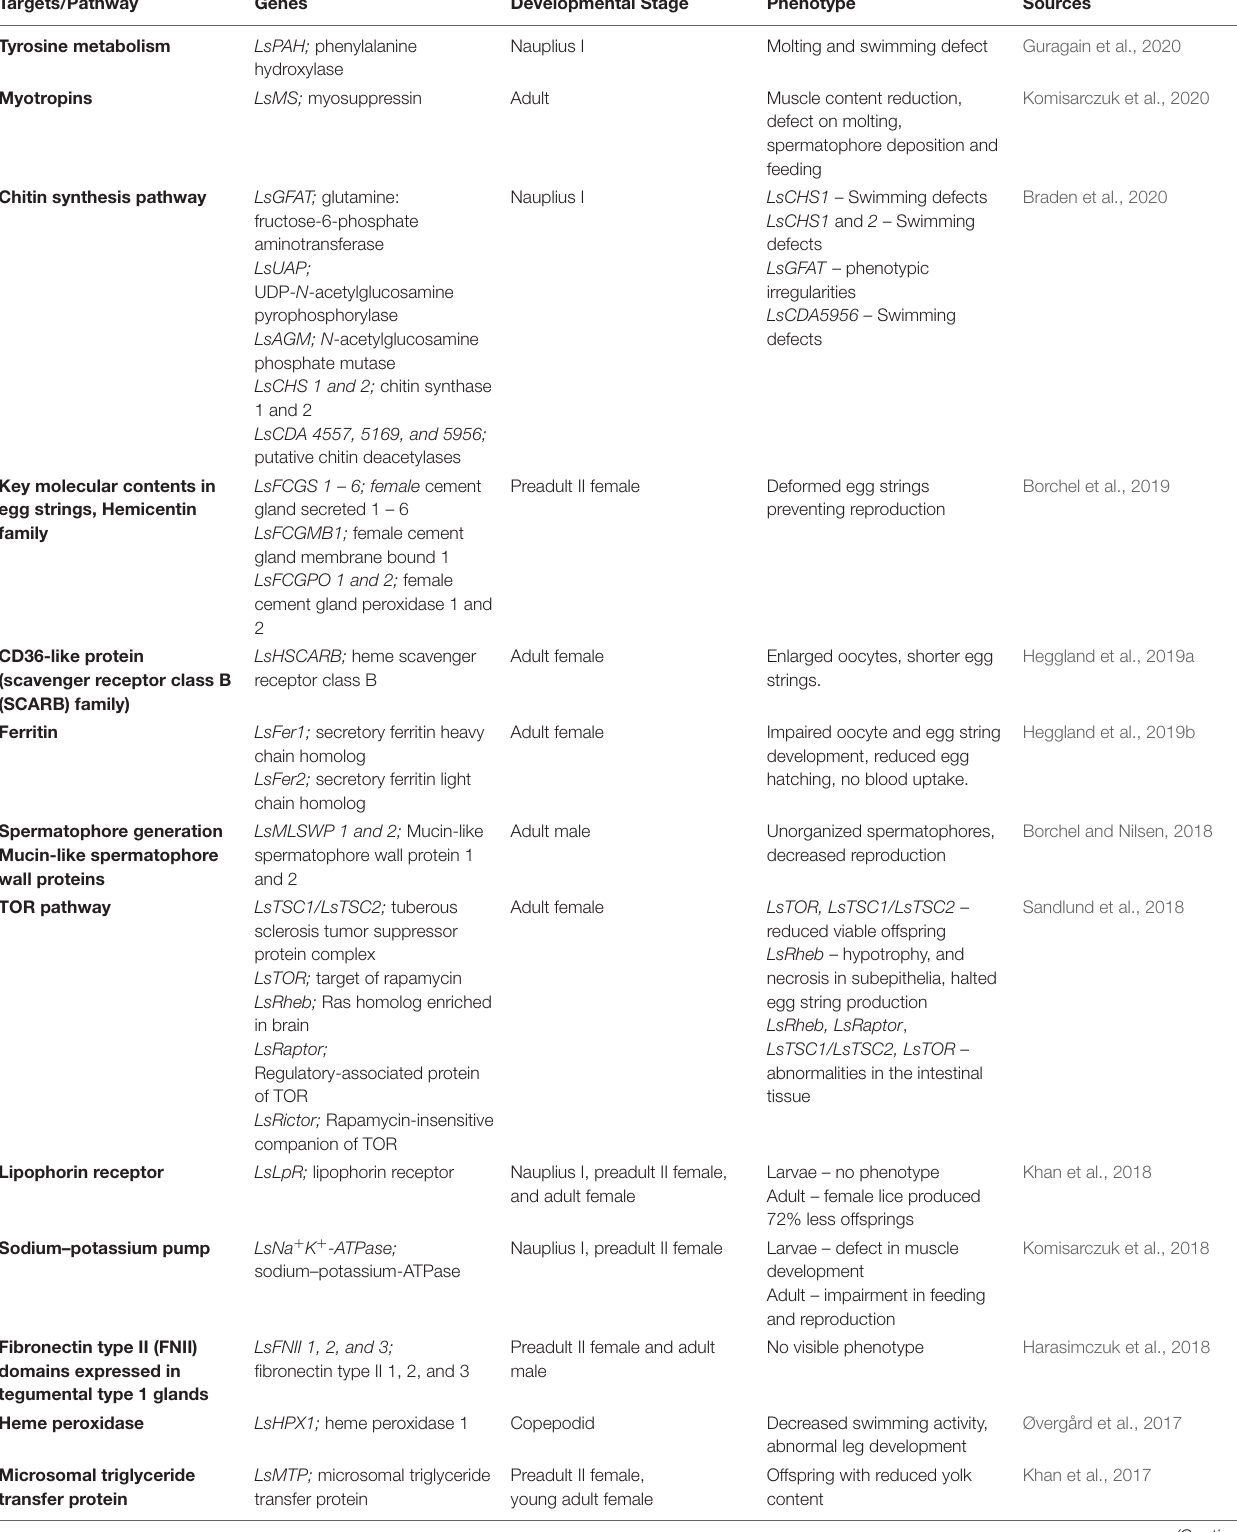
TABLE 4 | An overview of RNAi studies and their outcomes in Lepeophtheirus